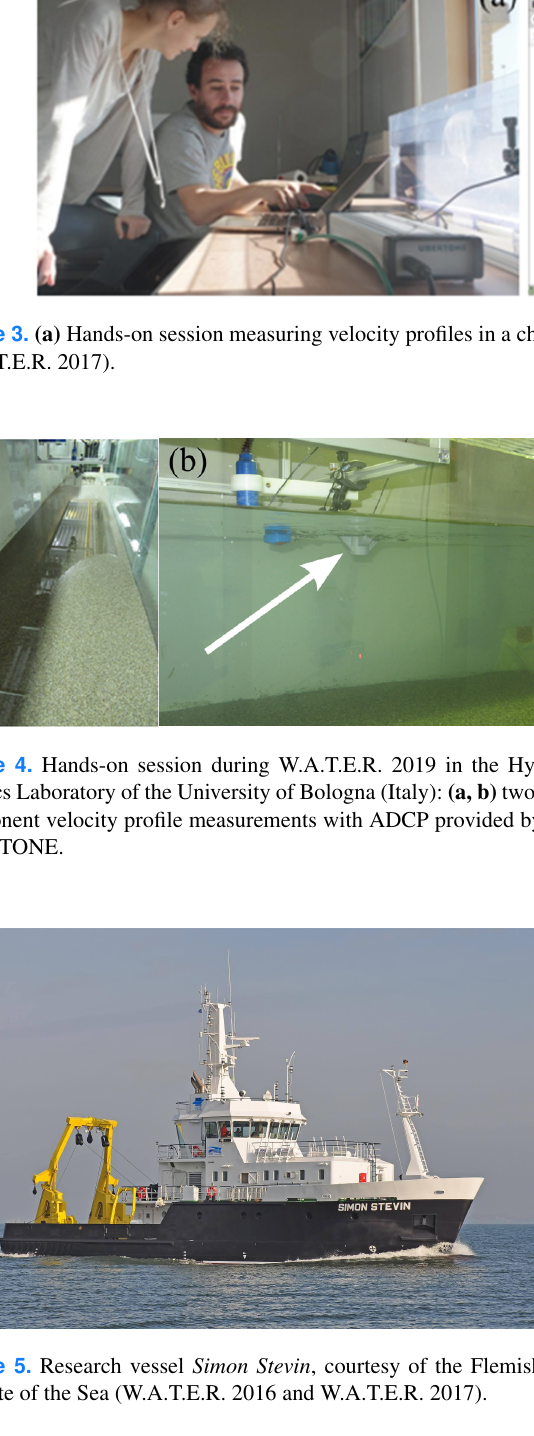
novel approaches, such as the use of unmanned vehicles (Fig. 7).